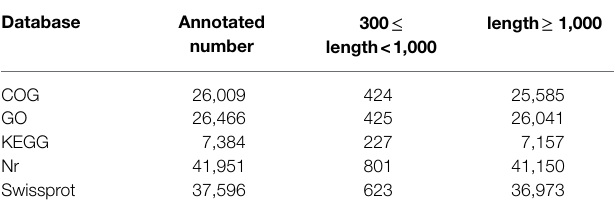
TABLE 3 | Summary of functional annotation of the Cunninghamia lanceolata transcriptome.